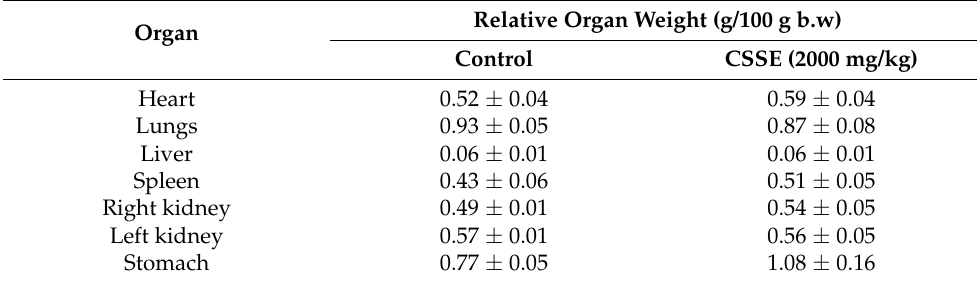
CSSE: C. sativus stigma extract. The values are expressed as mean ± SEM ( n = 6). No significant difference was recorded between CSSE-treated group and non-treated control ( p < 0.05, ANOVA I Tukey’s